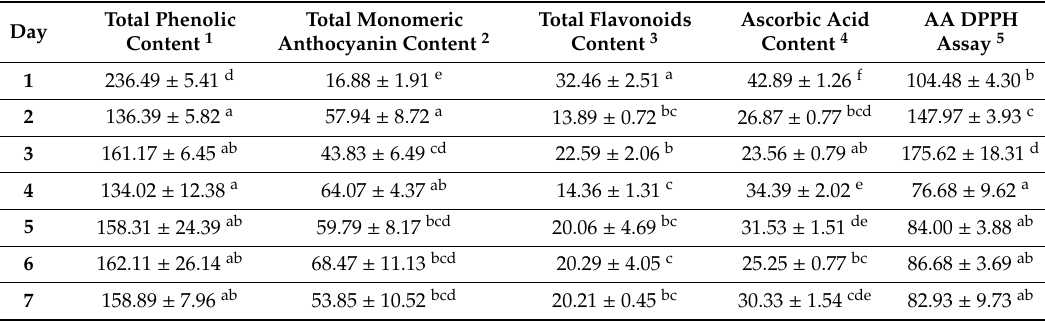
Table 4. Fruits stored at 1 ◦ C in fridge, packaged in PET (polyethylene terephthalate) film. E ff ect of storage period on the total phenolic content, total monomeric anthocyanin content, total flavonoid content, the ascorbic acid content, and the antioxidant activity DPPH parameters in red raspberries (cv. Erika). The results are the mean of three replicates ± Standard Deviation. ** ( P ≤ 0.01). The letters represent the significant di ff erence vertically at P ≤